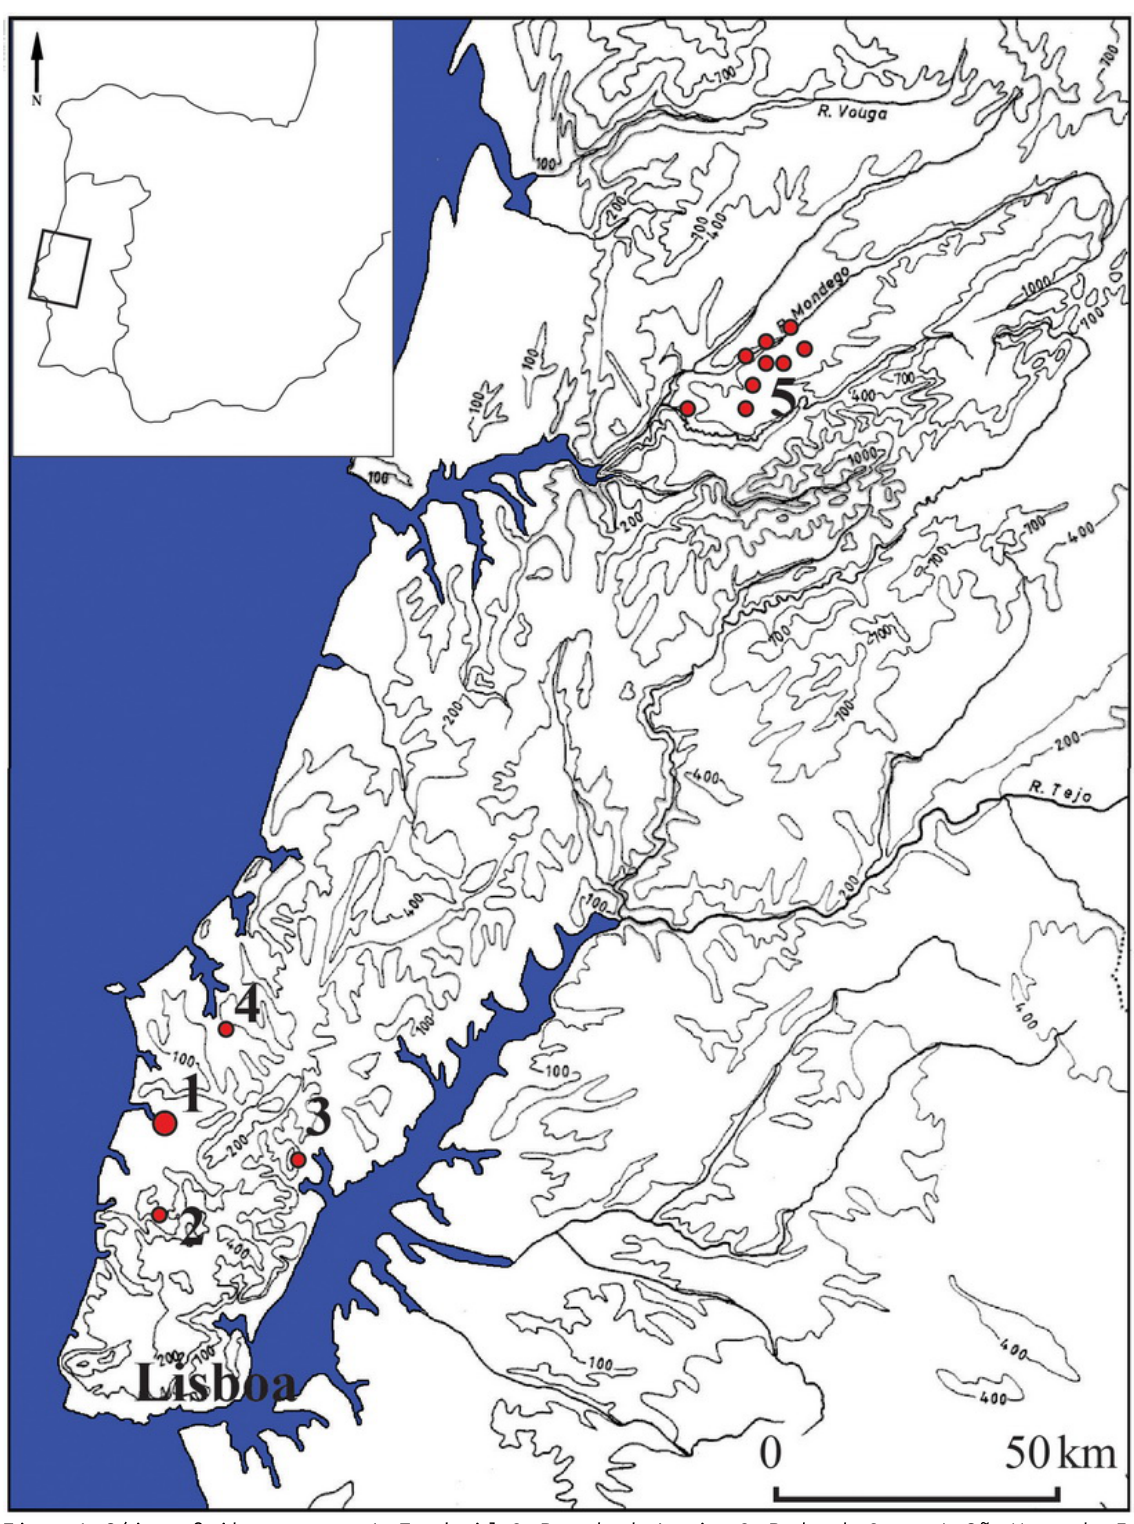
Figura 1 . Sítios referidos no texto: 1- Zambujal; 2- Penedo do Lexim; 3- Pedra de Ouro; 4- São Mamede; 5- Conjunto de necrópoles da Plataforma do Mondego (adaptado de Ventura & Senna-Martinez 2004). Figure 1. Mentioned sites in the text: 1- Zambujal; 2- Penedo do Lexim; 3- Pedra de Ouro; 4- São Mamede; 5- Necropolis group in the Plataforma do Mondego (modified from Ventura & Senna-Martinez